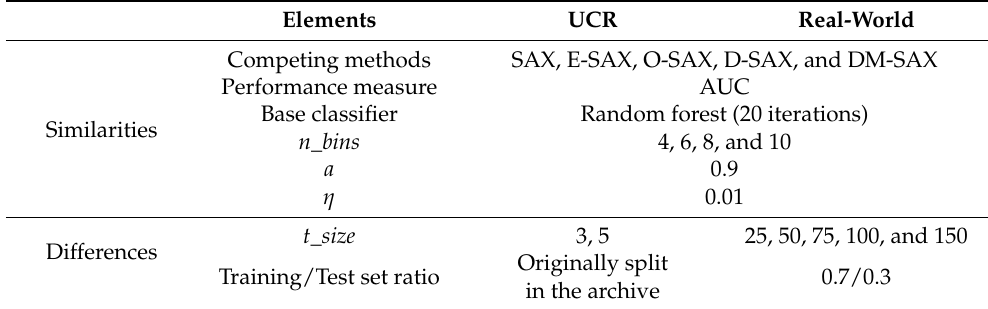
Table 7. Similarities and differences between experiments of UCR and real-world datasets.